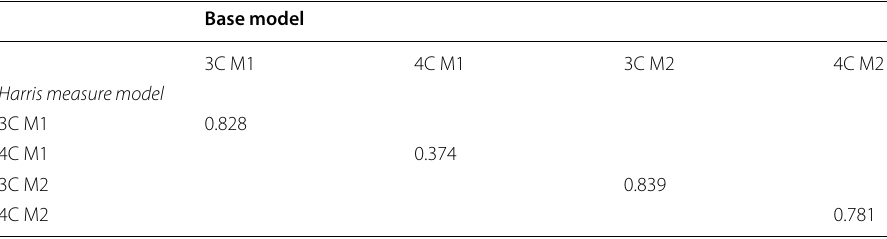
Table 4 Kendall rank